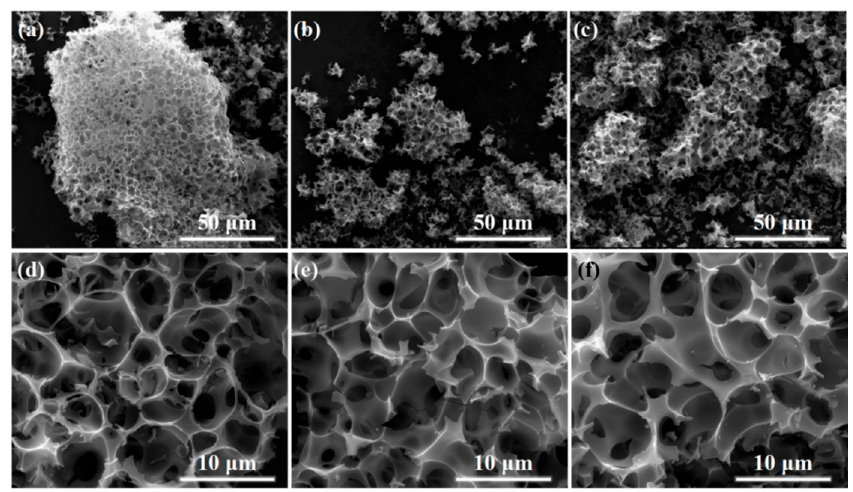
Figure 2. SEM images of ( a , d ) a-CSH-600, ( b , e ) a-CSH-700, and ( c , f ) a-CSH-800.